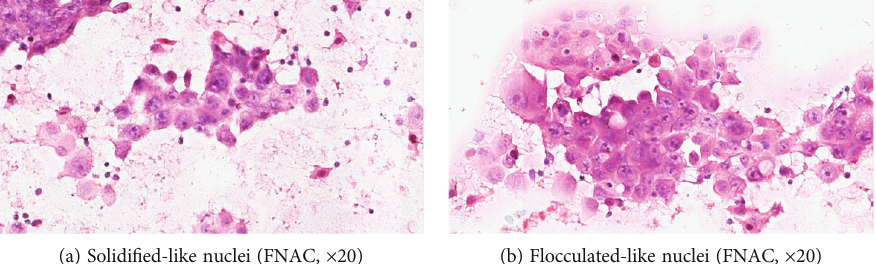
Figure 3: (a) Solidi fi ed-like nuclei and (b) fl occulated-like nuclei: prominent nucleoli and halos around the nucleoli or heterogeneous chromatin (FNAC, × 20).